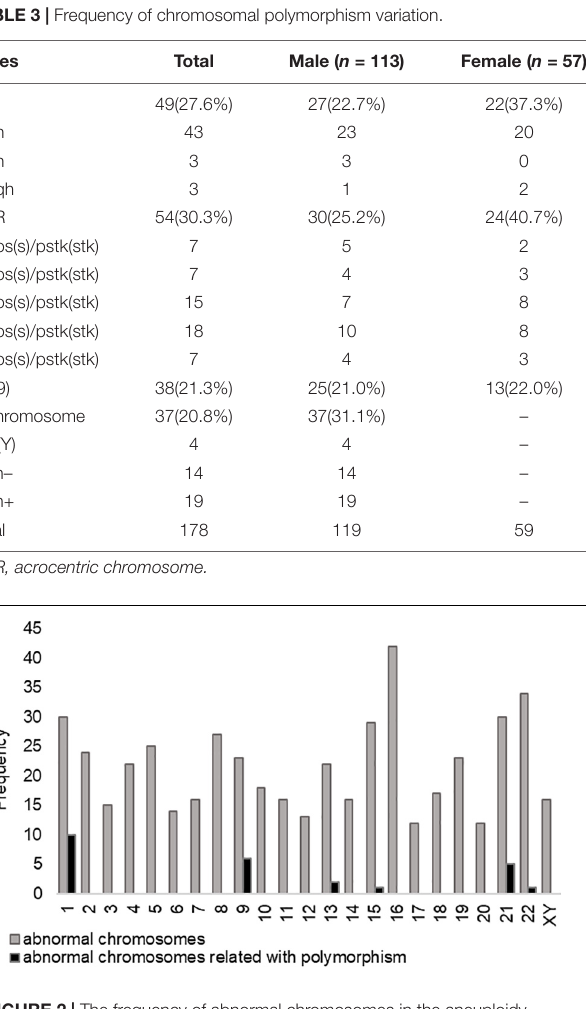
FIGURE 2 | The frequency of abnormal chromosomes in the aneuploidy embryos of polymorphism group. Chromosome 16 has the highest abnormal proportion in aneuploidy embryos, followed by chromosomes 22 and 1. The proportion of abnormal chromosomes associated with chromosome polymorphism (CPM) accounts for 5.04% (25/496) in all abnormal chromosomes, and chromosomes 1, 9, and 21 appear more frequently among related